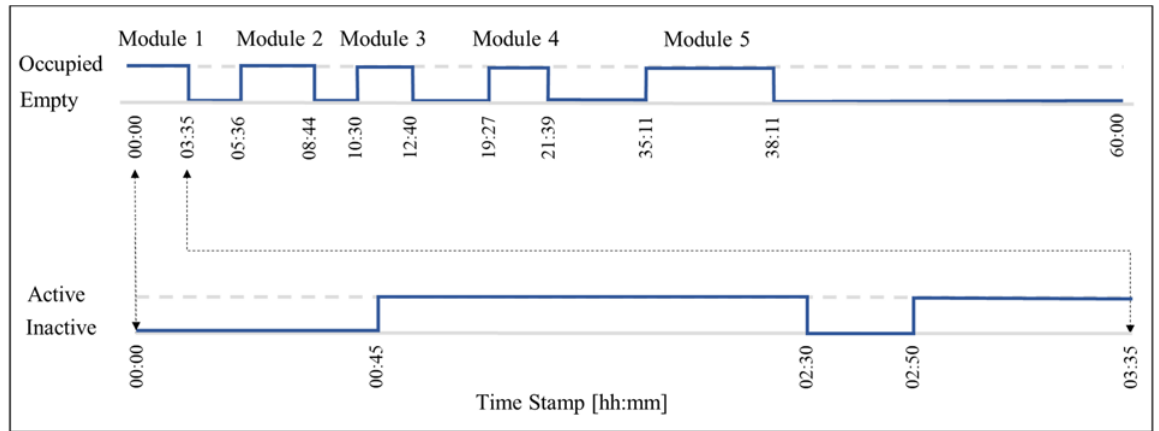
Figure 20. Active periods of workstation three during production of the first module.